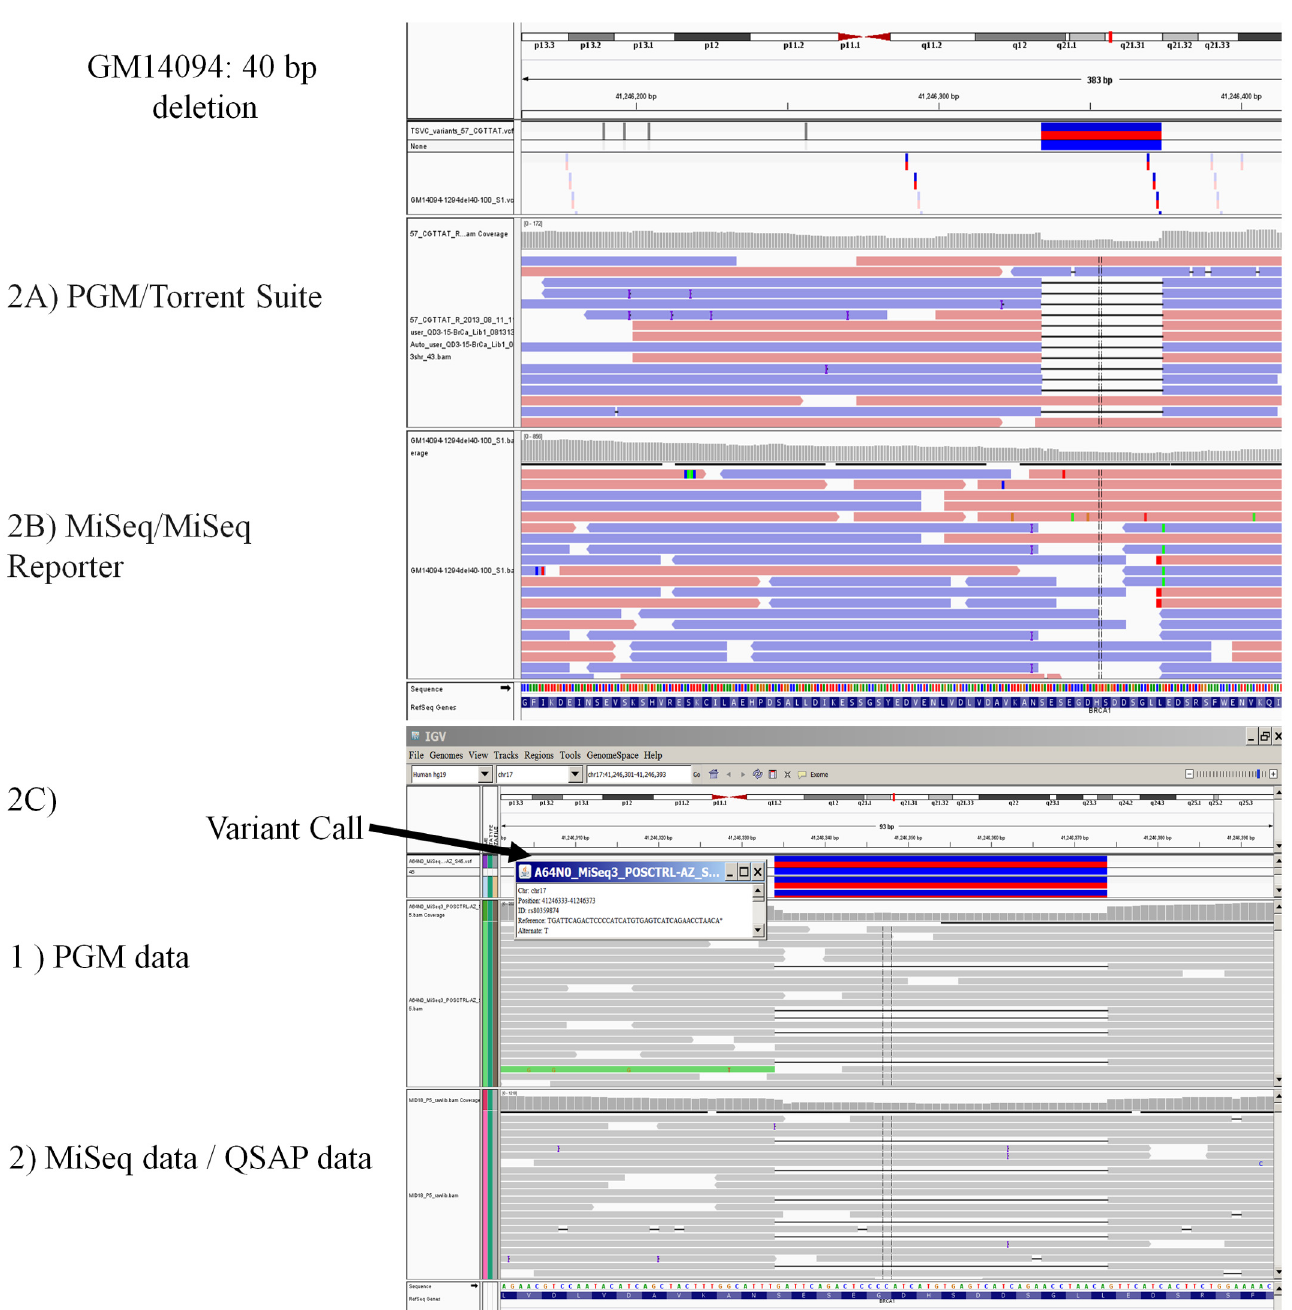
Fig 2. Alignment of a 40-bp deletion in BRCA1 (deletion c.1175_1214del40) in a validation sample. The Integrative Genomics Viewer (IGV) graphic report shows detection of the mutation with the PGM platform with Torrent Suite variant calling (panel A) but not the MiSeq platform with MiSeq Reporter (panel B). Use of QSAP with the MiSeq platform allowed detection of the deletion (panel C).